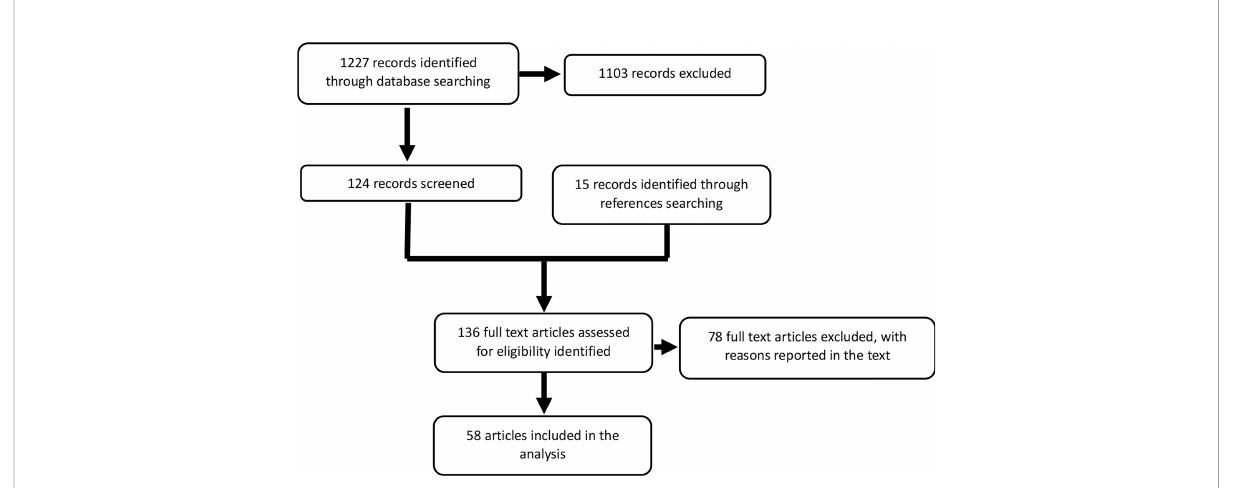
FIGURE 1 Consort diagram. The fi rst search yielded 1,227 papers, 124 of which were relevant to this analysis. Among the references, we identi fi ed 15 additional articles. The absence of information on treatment or survival outcome excluded 78 articles. The fi nal analysis included data from 58